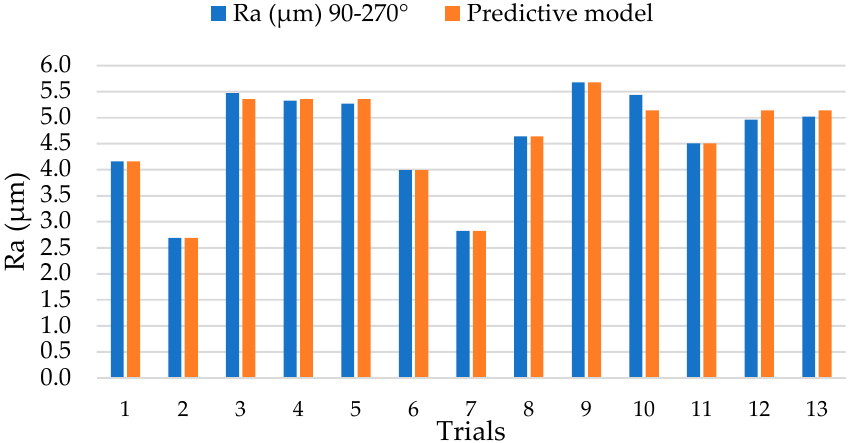
Figure 9. Comparison of Ra values between experimental tests and theoretical values of the predictive model for an orientation 90–270°.